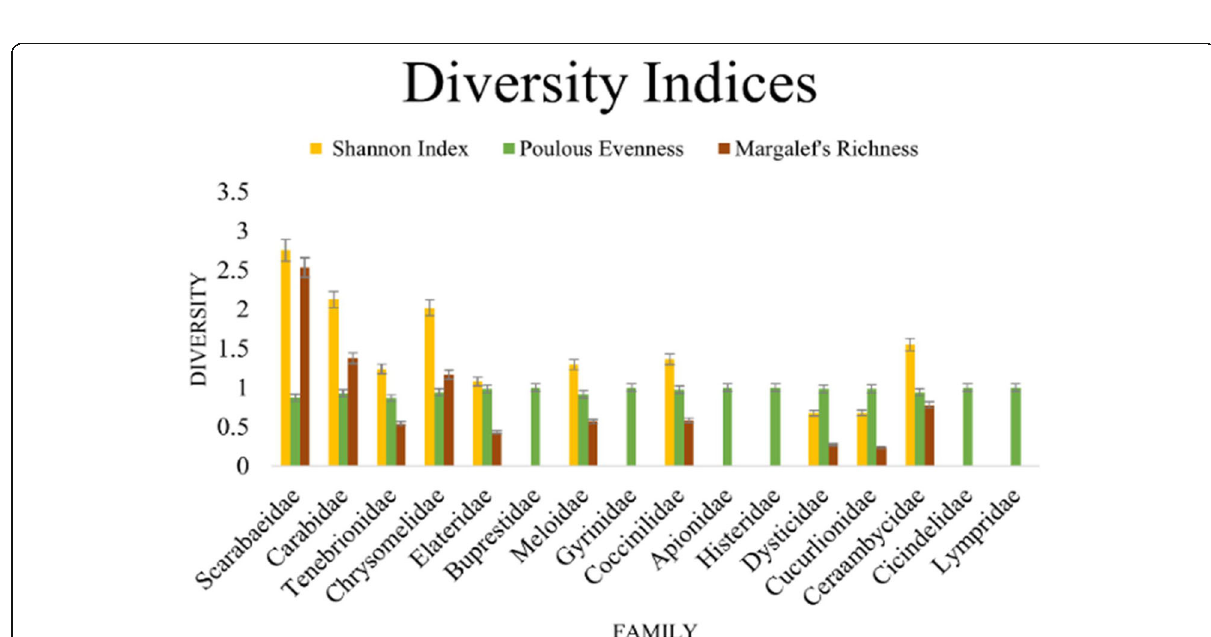
Fig. 2 Graph depicting the diversity indices, calculated for the obtained families in